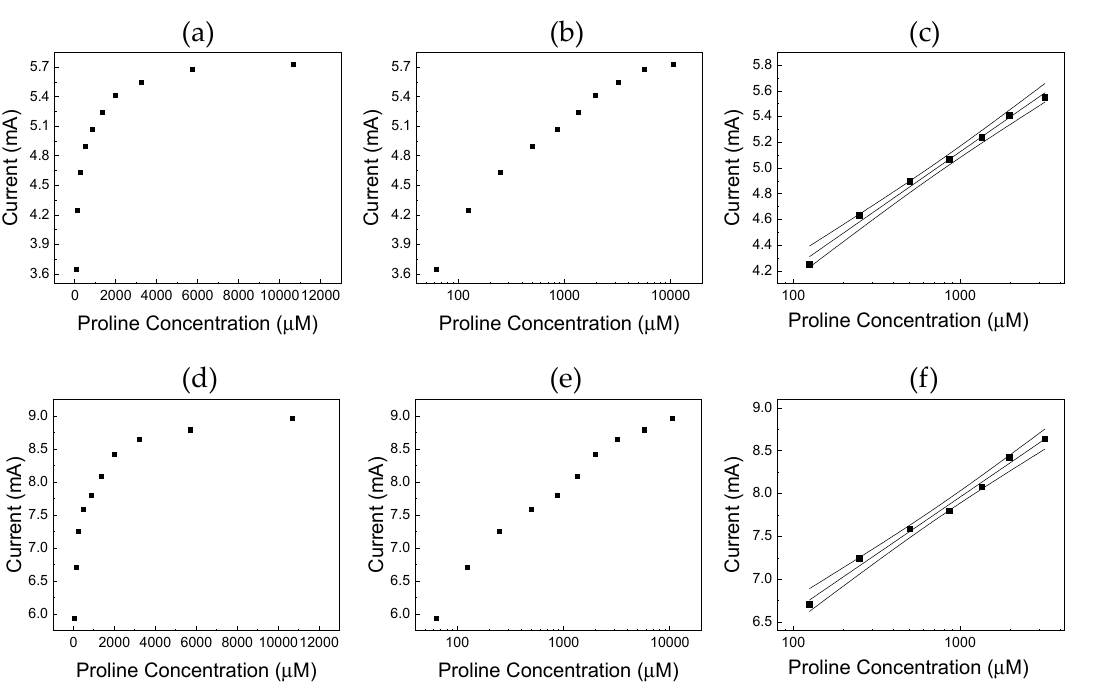
Figure 6. Calibration curves obtained, at first day of sensor fabrication, by increasing proline concentration between 63 μ mol L − 1 and 10.7 mmol L − 1 (H 2 O 2 concentration in solution equal to 1.5 mmol L − 1 ) and reading the current values at the oxidation ( a – c ) and reduction ( d – f ) peaks of CV curves. Curves ( a , d ), plotted using linear scales, show logarithmic trends; curves ( b , e ), plotted on semilogarithmic scales, show about linear trends; ( c , f ) straight-line intervals of curves ( b , e ). Each point represents the mean of three determinations. Table 1. Analytical method validation: main analytical data of the straight-line curves reported in Figure 6c,f, using oxidation peak and reduction peak,